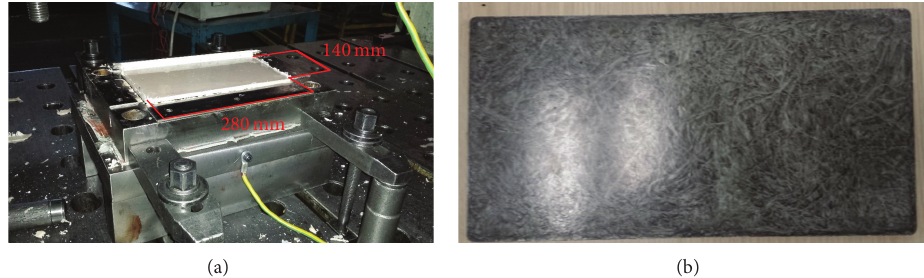
Figure 2: (a) SMC plate containing CaCO 3 filler in the mould and (b) SMC plate containing basalt filler.